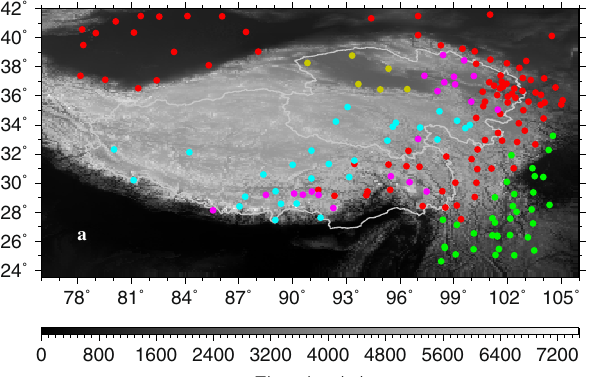
R 2 = 0.82 Slope= 0.19